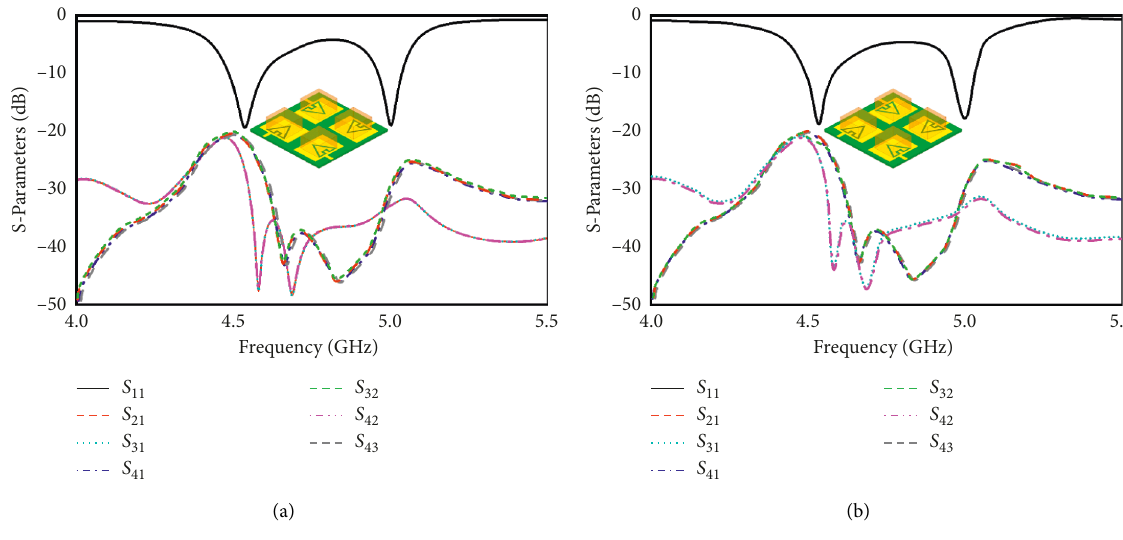
Figure 7: Scattering parameters (a) simulated and (b) measured.